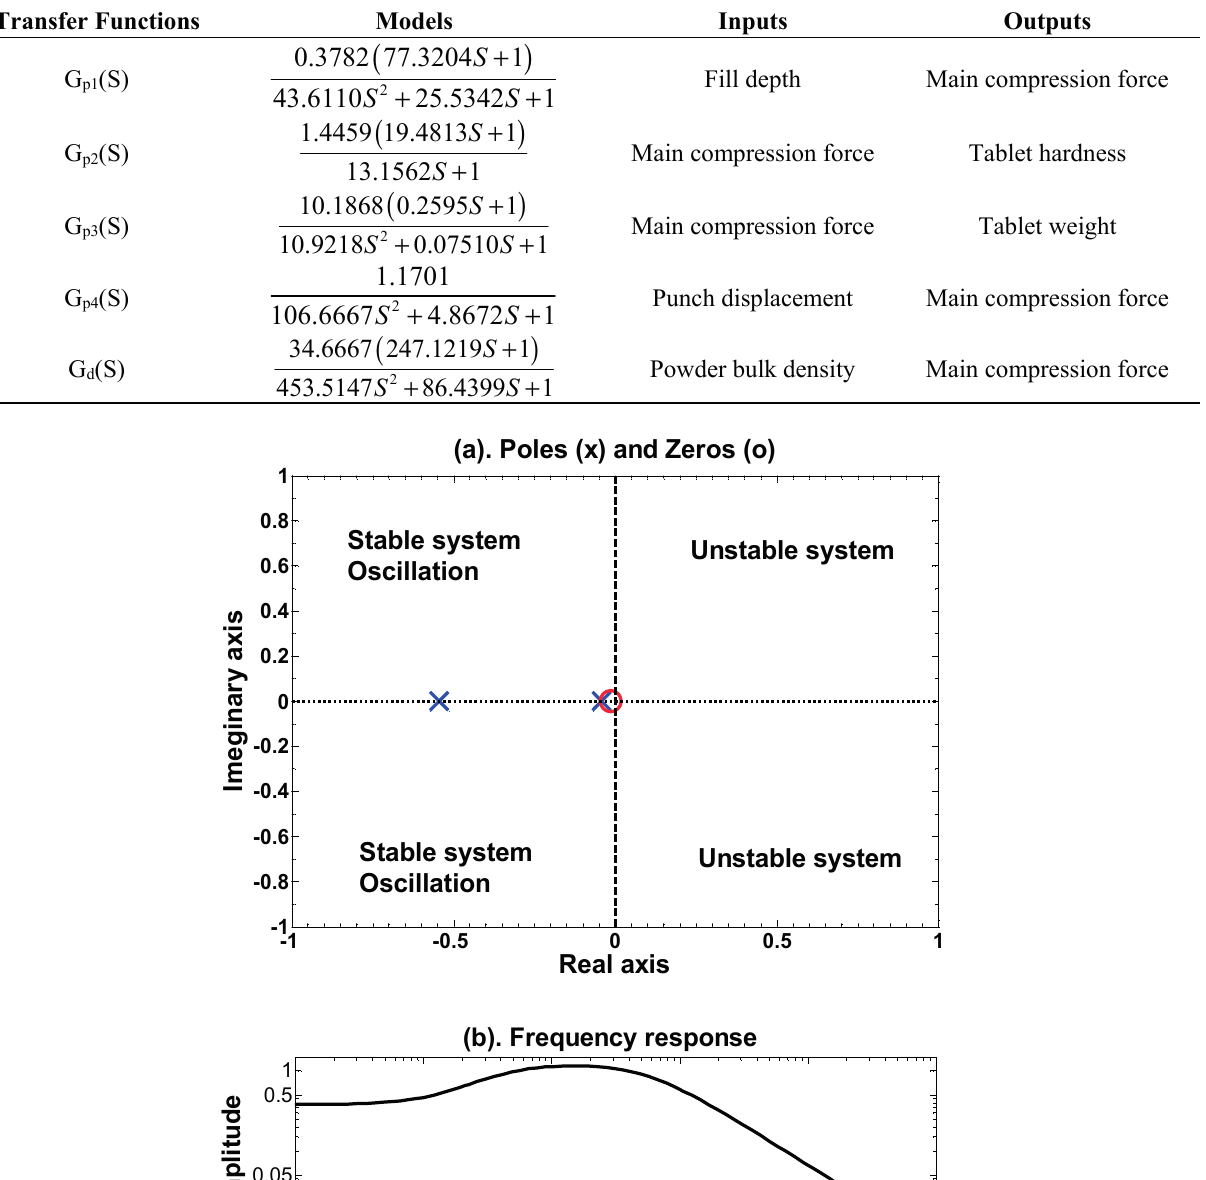
Table 1. Process transfer function model.